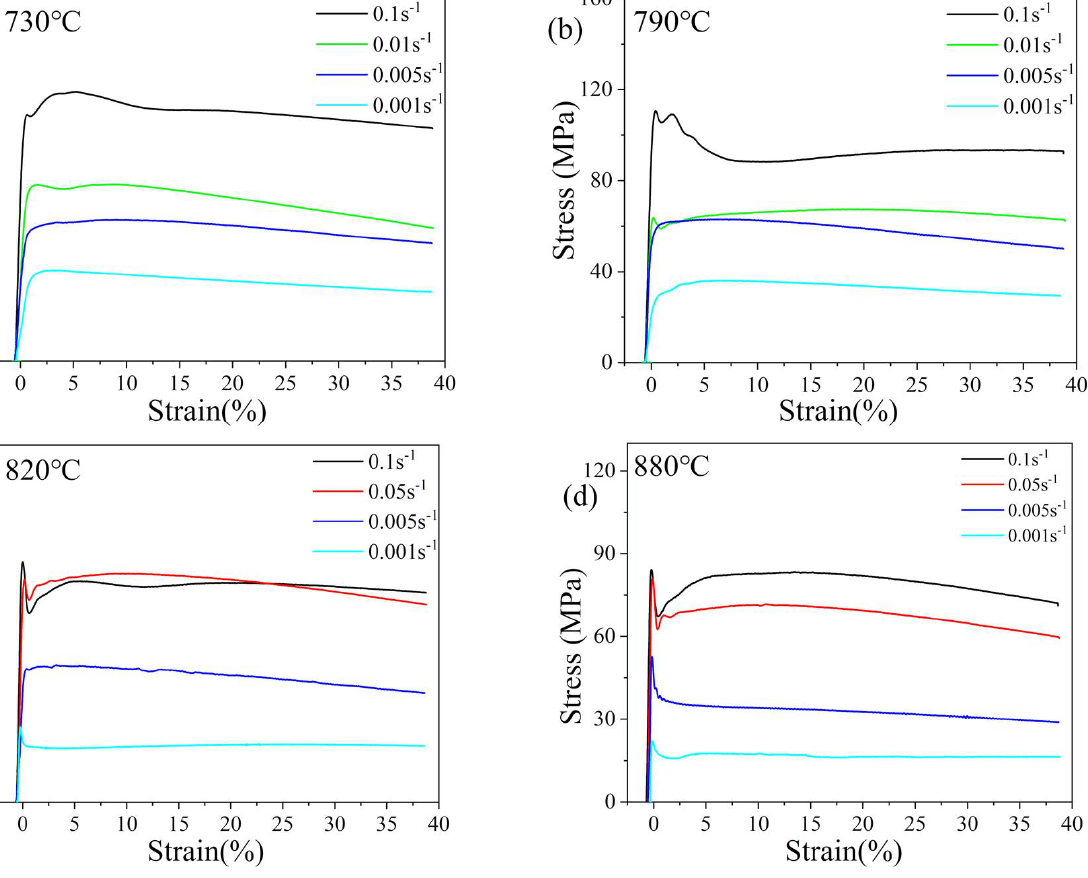
Figure 2. True stress-true strain curve: ( a ) 730, ( b ) 790, ( c ) 820, and ( d ) 880 °C . Due to the increase of material deformation, dislocations gradually accumulate at the boundary. When the critical value was reached, the effect of the softening mechanism, such as dynamic recovery, was greater than that of work hardening. It leads to the sudden decrease of flow stress and release of dislocations [3]. This is the reason why discontinuous yielding occurs in the yield point region. In the steady-state region, the flow stress decreases with the increase of deformation temperature and decrease of strain